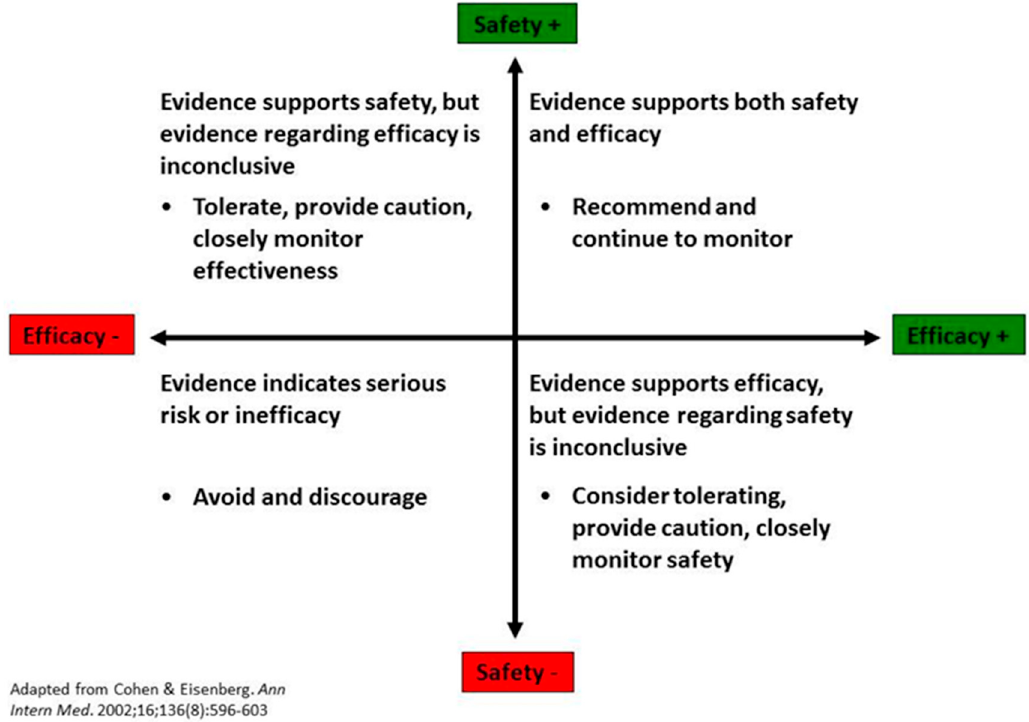
Figure 1. Safety–effectiveness therapy evaluation rubric.